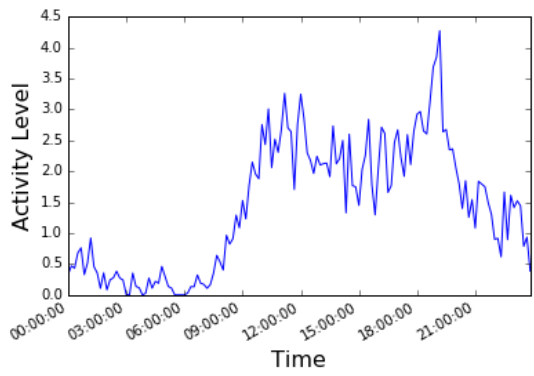
Figure 8. Variation of CDR activity over Milan for 24